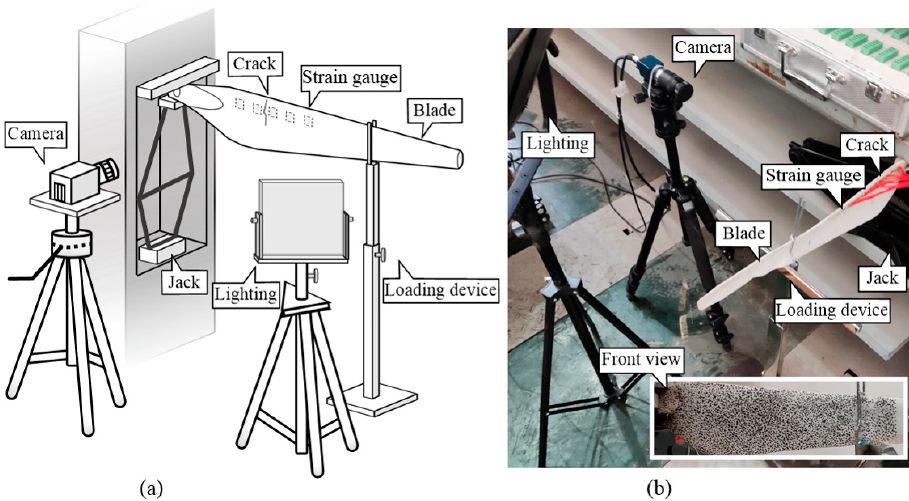
Figure 7. Blade damage detection setup: ( a ) Experimental setup; ( b ) Test site. An 8-bit gray level CMOS camera (Daheng MER503-G-P, Beijing, China) with a